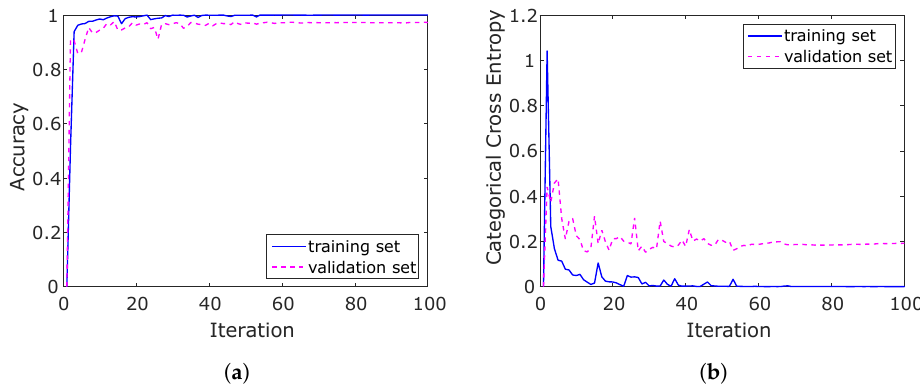
Figure 10. Training history of ( a ) accuracy and ( b ) categorical cross entropy